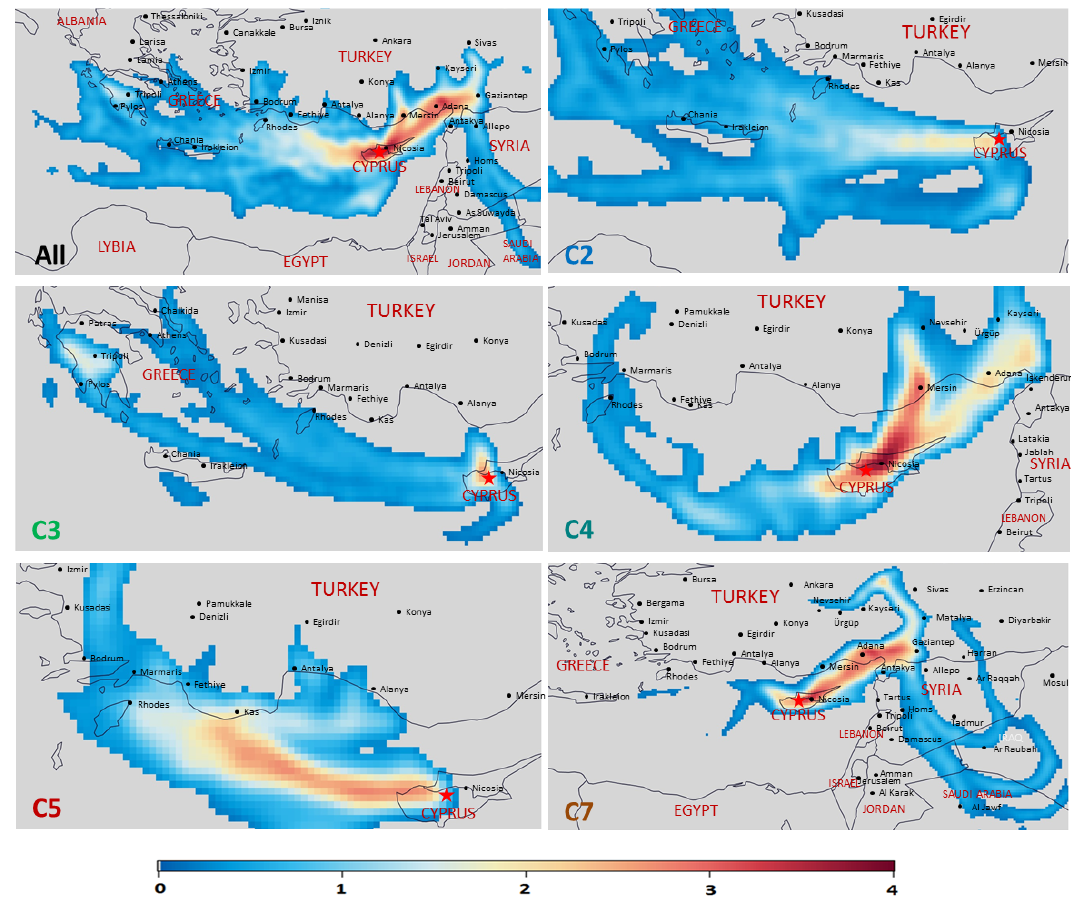
Figure 14. Potential source areas contributing to the VOC factor 6 in the function of air mass origins. Contributions are in units of µgm − 3 . All – without distinction of air mass origins; C2 – marine air masses; C3 – Europe; C4 – northwest Asia; C5 – west of Turkey; C7 – southwest Asia. The low numbers of samples associated with clusters 0 and 1 (local and N. Africa, respectively – Fig. 2) does not allow us to apply CPF analysis only considering these air mass